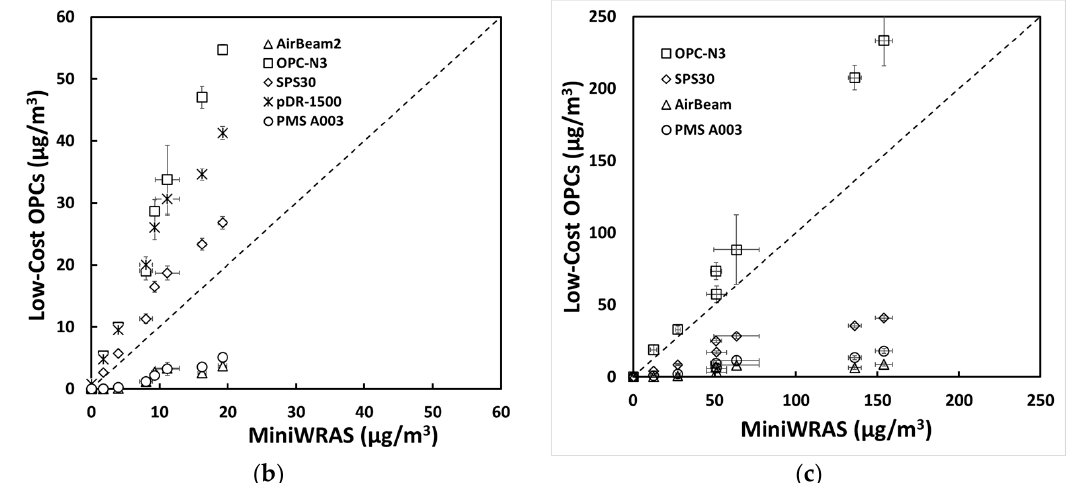
Figure 4. The mass concentrations (µg/m 3 ) of ( a ) PM 1 , ( b ) PM 2.5 mc, and ( c ) PM 10 reported by the sensors plotted against the reference device for the ARD environmental experiment.